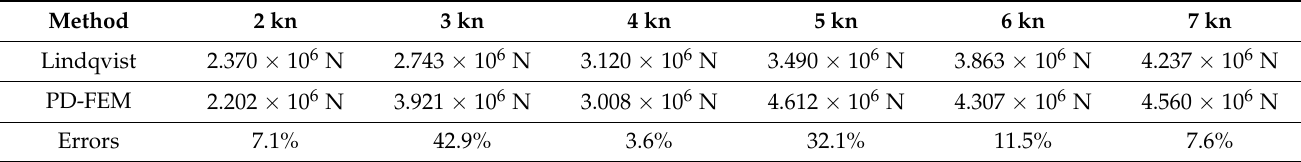
Table 5. Ice resistance calculated by PD-FEM coupling model and Lindqvist empirical formula.